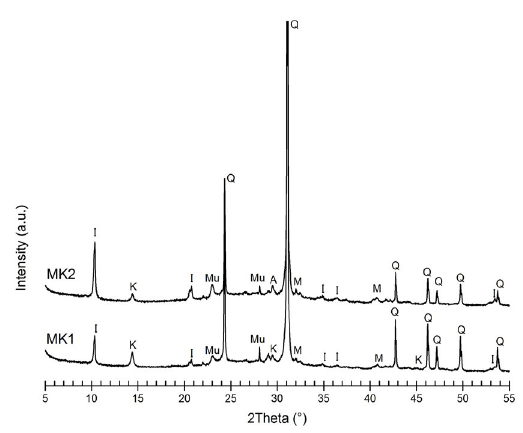
Si O (OH)); 2 2 5 (AlSi O )(F,OH) ; 2 3 10 2 O)(Al,Mg,Fe) 3 2